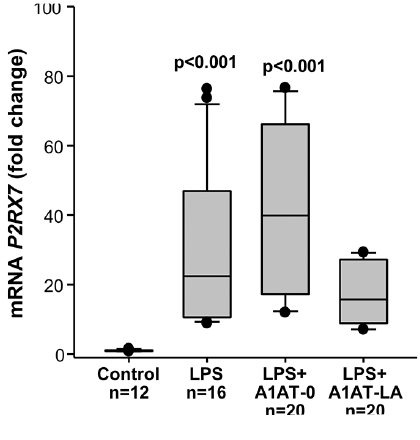
Figure 6. Effects of A1AT-0 and A1AT-LA on LPS-induced P2RX7 expression Human neutrophils (5 × 10 6 ) were incubated for 5 h in either medium alone or medium con- taining LPS (20 ng/mL) in the absence or presence of A1AT-0 (1 mg/mL) or A1AT-LA (1 mg/mL). mRNA expression of the P2RX7 gene was analyzed by real-time qPCR as described in Materials and Methods. GAPDH and GUSB were used as house- keeping genes. Box plots represent data from 4 individual donors; n = number of replicates for each experiment. P value in- dicates significant differences compared with the values seen in control